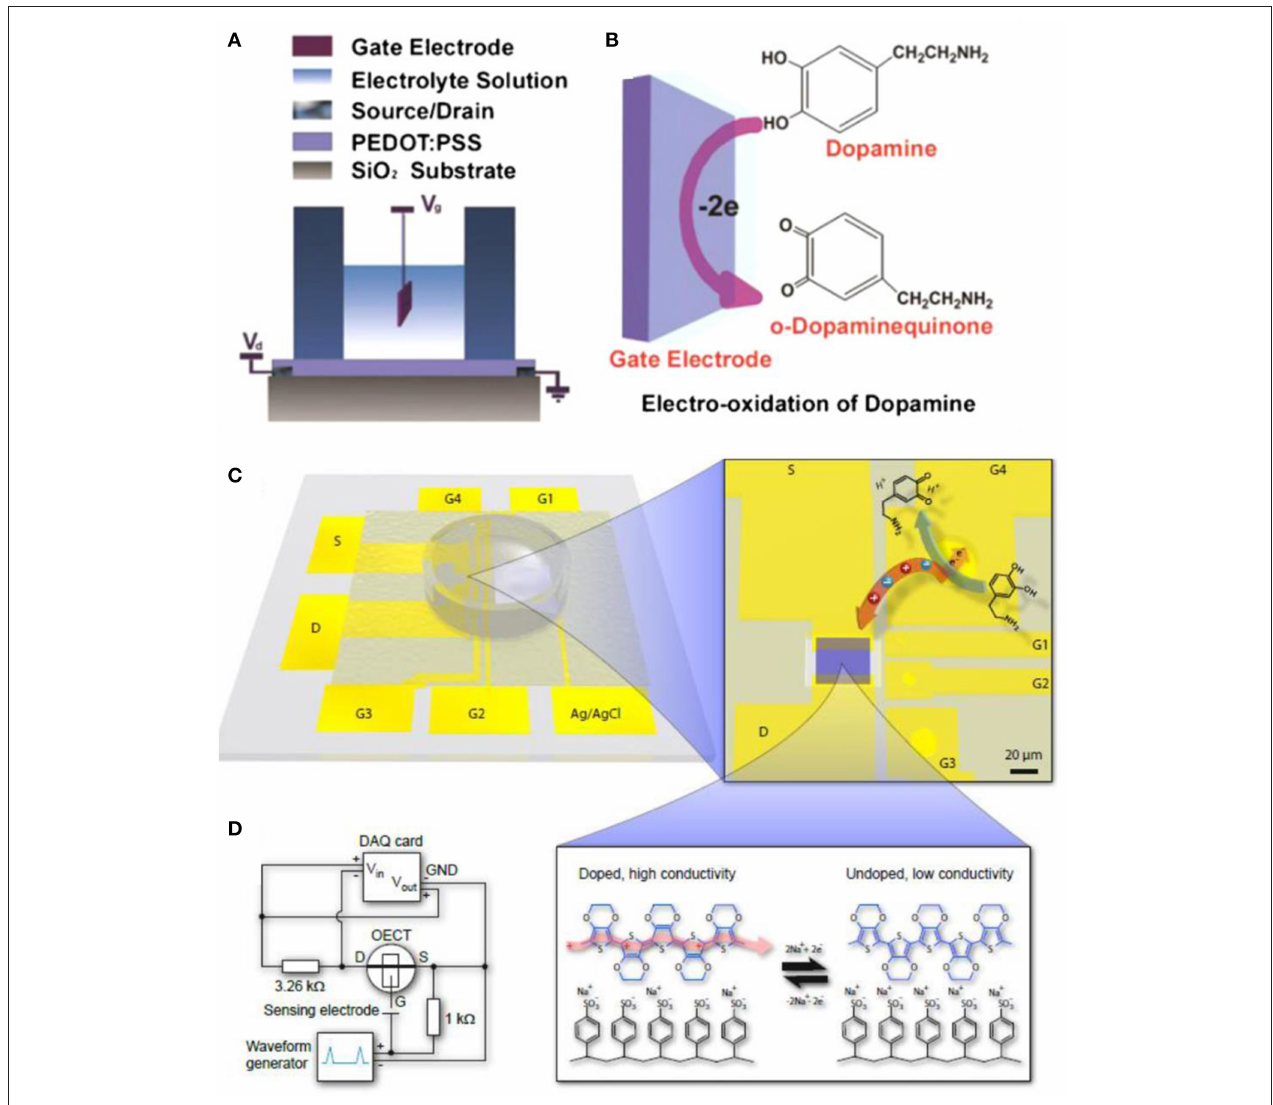
FIGURE 5 | (A) Illustration of OECT-based dopamine biosensor that PEDOT: PSS act as the conducting channel. (B) The oxidization of dopamine on the surface of the gate electrode (Tang et al., 2011). (A,B) reproduced with permission (Tang et al., 2011). Copyright © 2011 Elsevier B.V. All rights reserved. (C) The OECT device and gate electrodes built by patterned gold. And the illustration of dopamine oxidized on the Au gate shifting the doping state of the PEDOT: PSS channel (D) Experimental device circuit used for the OECT-amplified FSCV (Tybrandt et al., 2014). (C,D) reproduced with permission (Tybrandt et al., 2014). Copyright © 2014